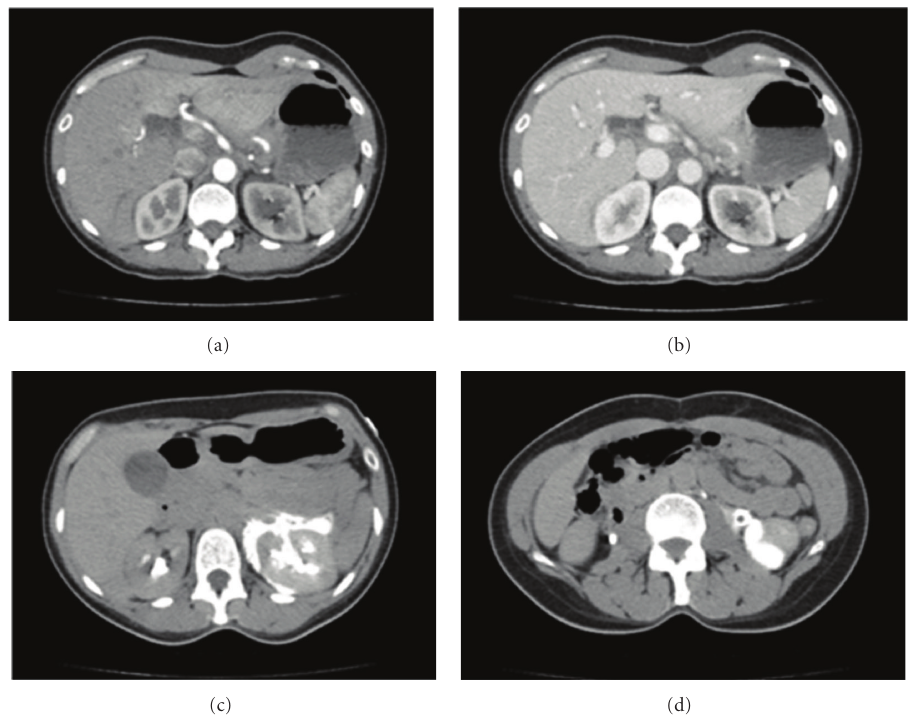
Figure 1: (a) CT arterial phase, (b) CT venous phase, (c) and (d) CT with delayed venous phase showing renal extravasation of IV